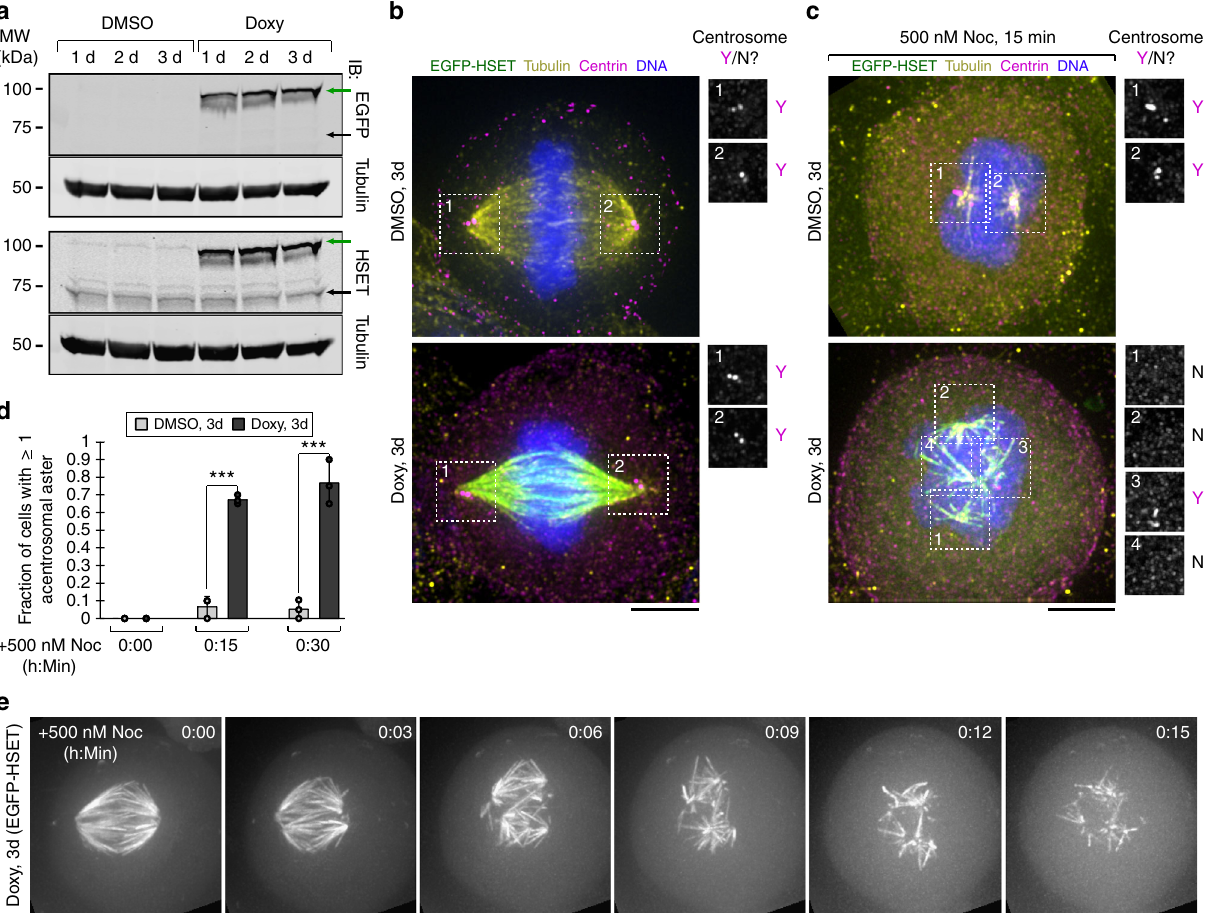
Fig. 6 Increasing the relative level of soluble (non-MT) tubulin promotes HSET-driven aster formation in cells. a Generation of a transgenic HeLa cell line where EGFP-HSET expression is under control of doxycycline. Western blot of whole cell lysates probed with antibodies that recognize EGFP, tubulin, and HSET. Numbers indicate days of induction with doxycycline/DMSO. Green arrow indicates overexpressed EGFP-HSET, and black arrow represents endogenous HSET. b Maximum intensity z -projections of metaphase EGFP-HSET HeLa cells treated with DMSO (top) or doxycycline (bottom) for 3 d, then fi xed and stained with antibodies against tubulin (yellow), centrin (magenta) or Hoechst (DNA, blue). Numbered boxes correspond to spectrally unmixed centrin-stained regions shown on right. Y/N indicates the presence of centrin at spindle poles. Scale bar, 5 µ m. c EGFP-HSET HeLa cells were pretreated with DMSO (top) or doxycycline (bottom) for 3 d, then treated with 500 nM nocodazole (Noc) for 15 min to increase the relative levels of soluble tubulin. Cells were fi xed, stained, and imaged identically to b and maximum intensity z -projections are shown. Scale bar, 5 µ m. d Quanti fi cation of b , c . After analyzing the tubulin/centrin channels, the fraction of cells containing ≥ 1 acentrosomal aster was compared between 3 d doxycycline/DMSO cells after treatment with 500 nM nocodazole for 0, 15, and 30 min. Overlaid dots represent the average observed fraction for each independent experiment. *** p < 0.001 by two-tailed t -test. Data were reported as the average ± SEM of N = 3 independent experiments with n ≥ 60 cells for each condition. e EGFP-HSET HeLa cells were treated with doxycycline for 3 days to induce maximal expression, and 500 nM nocodazole was added to increase relative levels of soluble tubulin. Maximum intensity z -projections were acquired in the EGFP channel every 3 min and a representative time-course is shown for the indicated